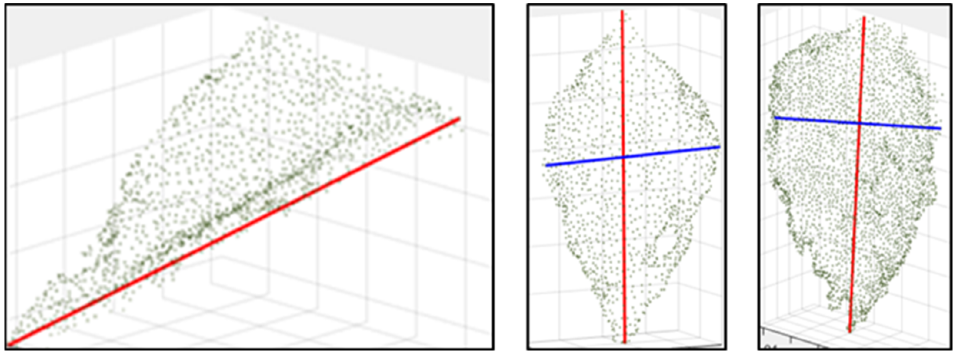
Figure 13. Application of transformation algorithm for automatic measurement: ( A ) basic point cloud of leaves; ( B ) point cloud of the leaf that has undergone coordinate transformation.